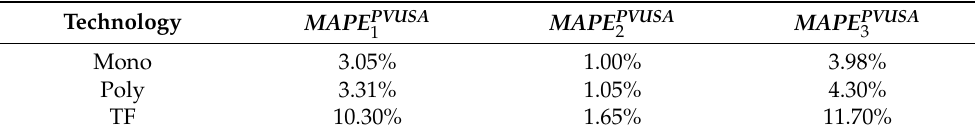
and P PVUSA , MAPE PVUSA 1